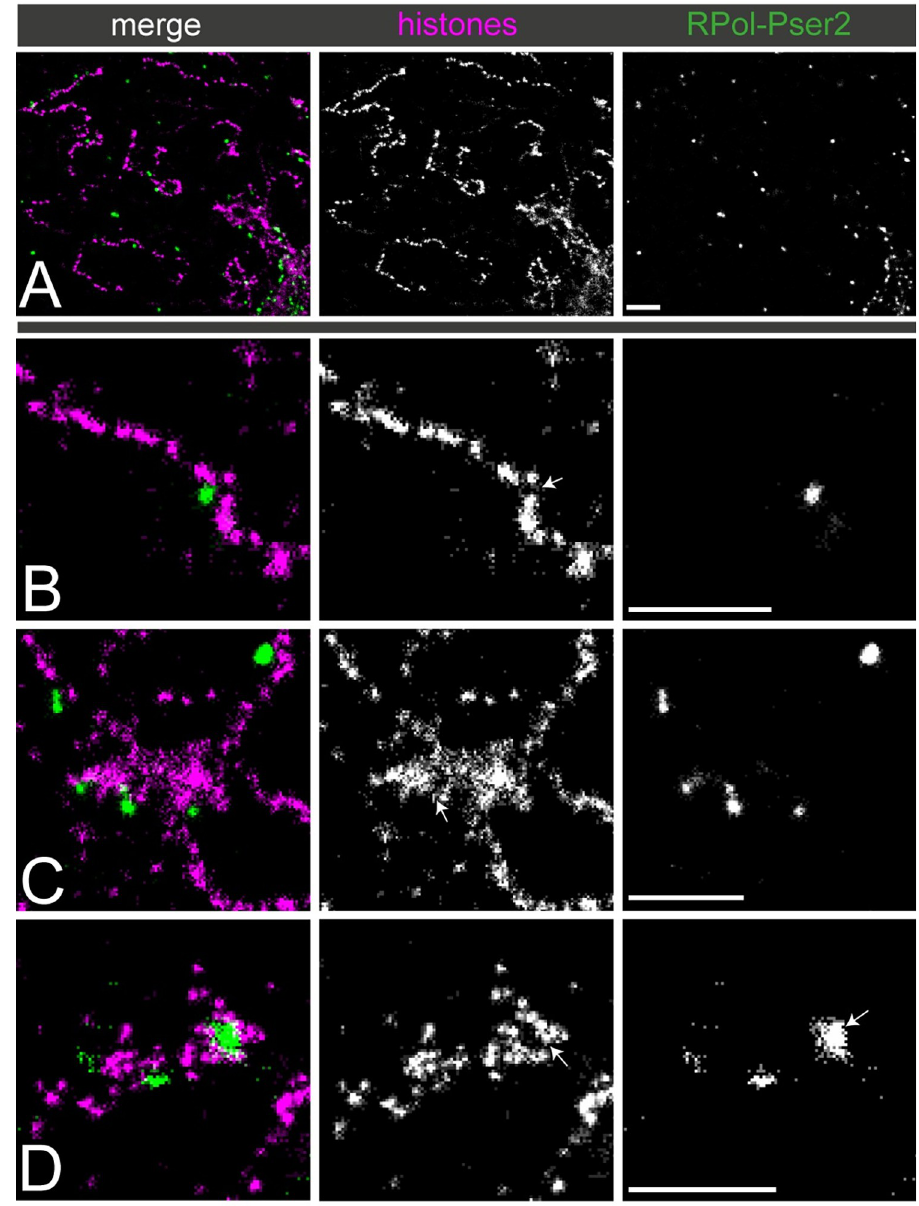
Fig 5. The association between Y loop chromatin clusters and active polymerase (RPol-PSer2). Dual-colour STORM images of immunolabelled histones (magenta) and RPol-Pser2 (green). (A) gives an overview showing that polymerase foci are less prevalent than nucleosome clusters. (B to D) show selected examples at higher power. (B) An example of an individual Y loop fibre associated with one isolated focus of RPol-Pser2. RPol II appears to be associated with a looping region inbetween two nucleosome clusters, indicated with an arrow. (C) An example of larger aggregates of chromatin along the Y loops associated with RPol II. The foci of polymerase appear to be associated on the periphery of the aggregates, with some evidence of looping regions, indicated with an arrow. (D) An example of a larger focus of RPol II associated with Y loops. This larger focus could indicate a cluster of polymerase complexes co- transcribing as a “factory”. These are rare to see, and do not seem to represent a universal organisation of transcription along the Y loops. Scale bars are 1 μ